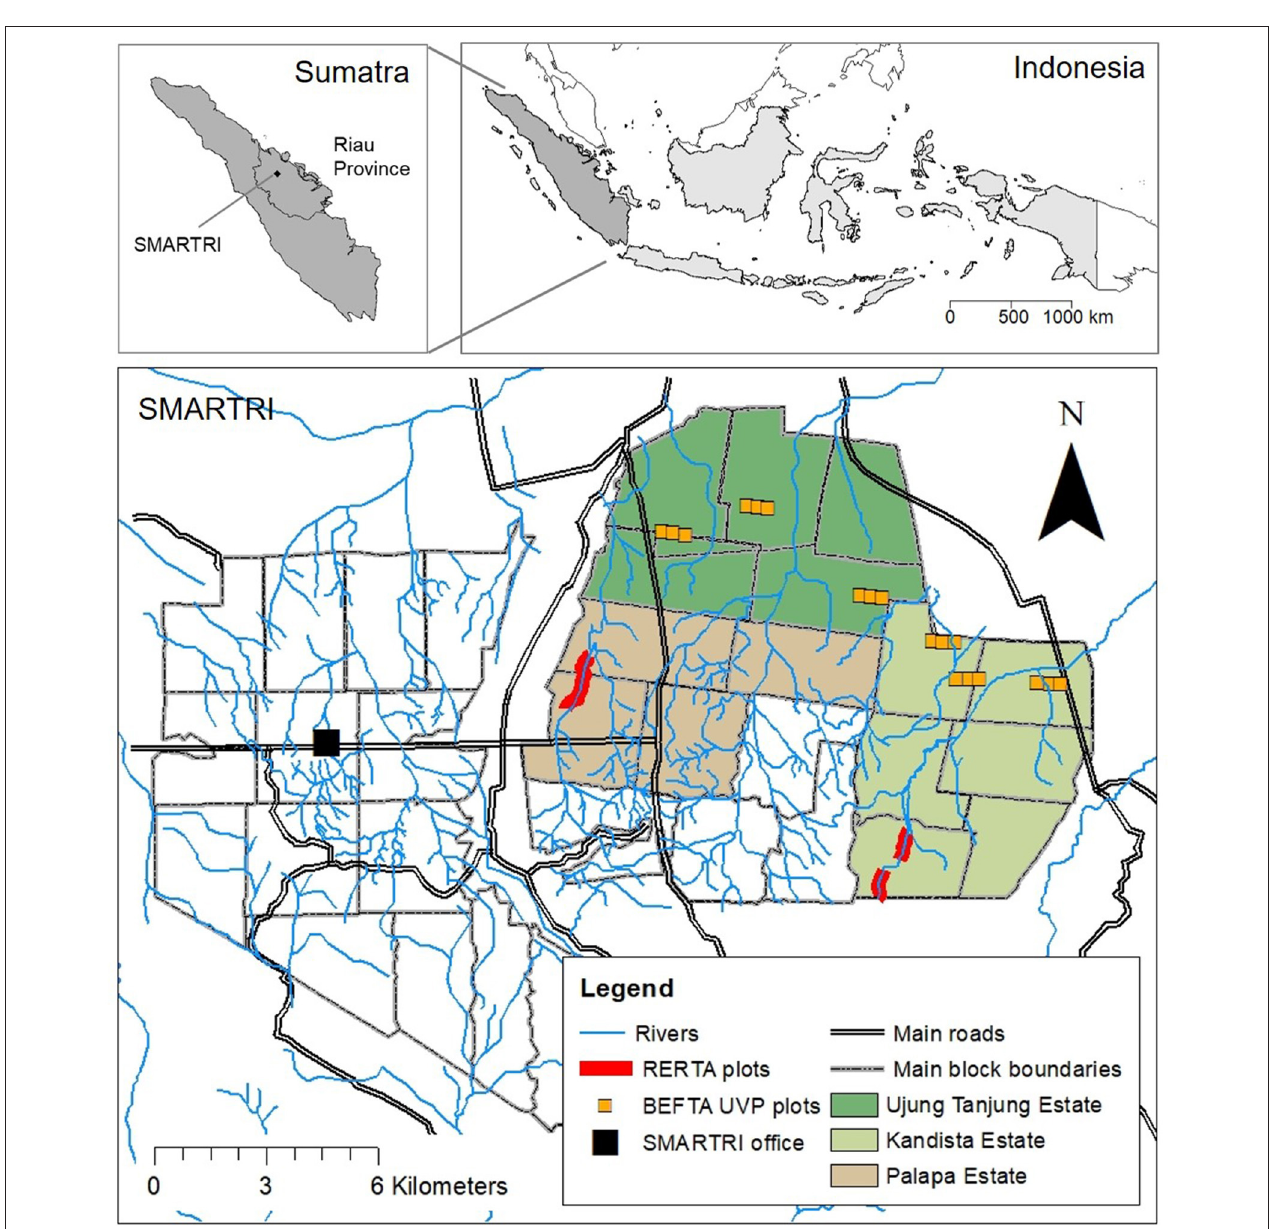
FIGURE 1 | Maps to show the location of our experimental plots within the SMARTRI landscape and within Sumatra and Indonesia. BEFTA Understory Vegetation Project (UVP) plots are set up in triplets across Ujung Tanjung and Kandista Estates; RERTA 1 is set up in Palapa Estate; and RERTA 2 is set up in Kandista Estate. Maps were made using ArcMap 10.5.1 [Environmental Systems Research Institute (ESRI), 2017], library “maps” in R statistical package (Brownrigg, 2016; R Core Team, 2017), and with reference to maps produced by Sinar Mas. palms are planted in rows ∼ 8 m apart. Rows are staggered so that neighbouring palms are arranged in a triangular